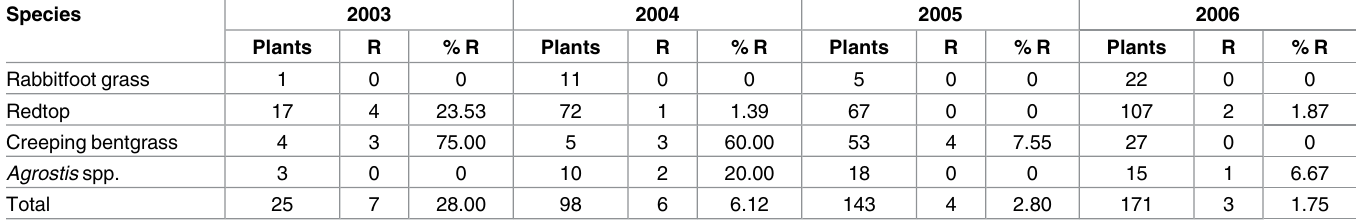
Table 2. Percentage of susceptible established plants that produced at least one transgenic seedling. Number of susceptible plants that produced transgenic glyphosate-resistant seedlings (R) of the total number of glyphosate-susceptibleplants (Plants) of each speciesfrom whichpanicleswere collected and seed tested for 2003 through 2006. The % R is the percentage of susceptibleplants sampledthat produced glyphosate-resistant